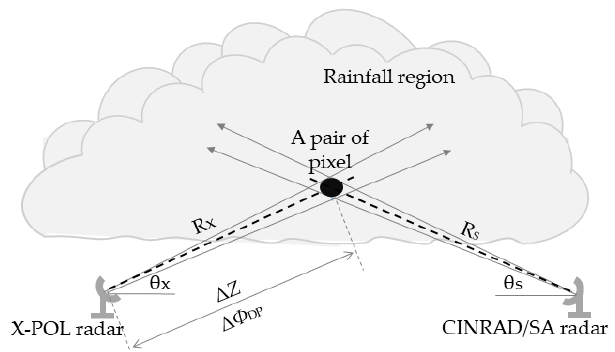
Figure 2. Theoretical diagram of RIC methods. The pair of pixels (black ellipse) in the rainfall region respectively comes from the X-POL radar and the CINRAD / SA radar. Since attenuation generally increases with distance, to ensure that the observation time between two radars is close and the distance and height of X band and S band pixels is equal, the basic conditions to form a pair of pixels are as follows: (1) the absolute di ff erence between the distance (R X )from the X-POL radar pixel to the X-POL radar station and the distance (R S ) from the CINRAD / SA radar pixel to the CINRAD / SA radar station is less than 10 km, i.e., | R X − R S | < 10 km; (2) the absolute di ff erence of volume scanned time between X-POL and CINRAD / SA radars are within 2 min, i.e., | T X − T S | < 2 min; (3) the absolute di ff erence of the viewing angle between CINRAD / SA and X-POL radars is less than 0.01, i.e., | θ X − θ S | < 0.01 deg. ∆ Z is the total rain attenuation value of X band reflectivity on the path of long R X , i.e., path-integrated attenuation PIA in Equation (2), and ∆ Z can here be approximately replaced with the di ff erence between S band reflectivity and X band reflectivity in the pixel pair, i.e., ∆ Z (S–X) in Equation (4). ∆ Φ DP is the corresponding change of Φ DP on the path of long R X